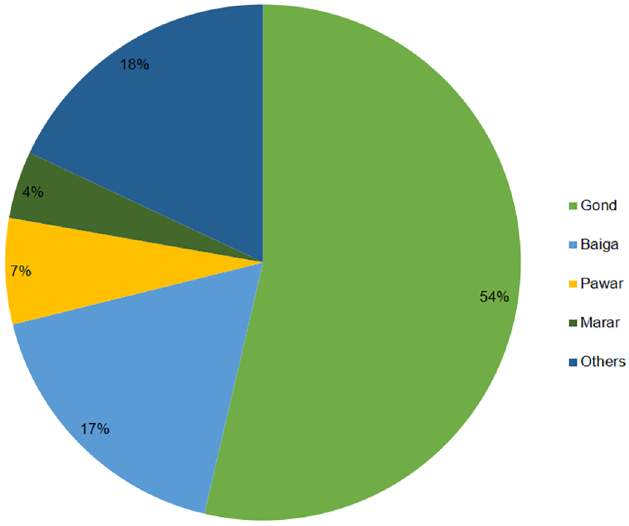
Fig 3. Composition of sloth bear attack victims as per social